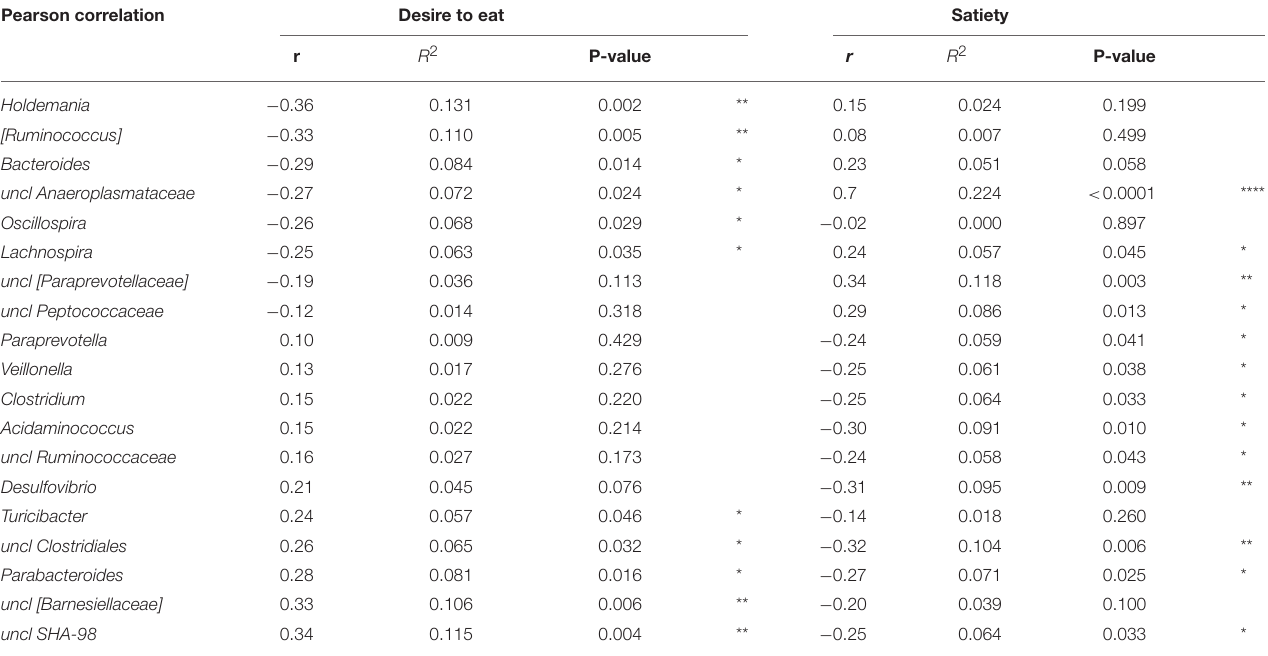
TABLE 2 | Pearson correlation of bacterial genera and subjective feelings of appetite. Pearson correlation Desire to eat Satiety r R 2 P-value r R 2 P-value